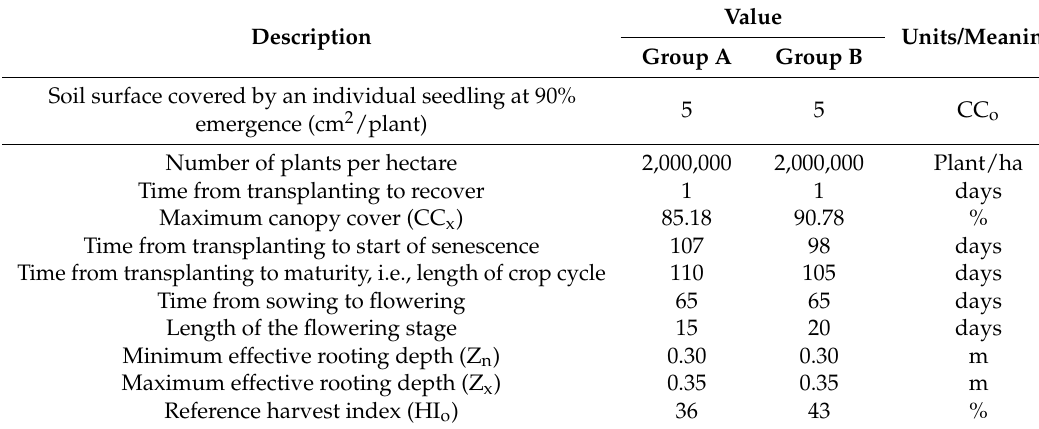
Table 2. Cultivar-specific parameters input into the AquaCrop